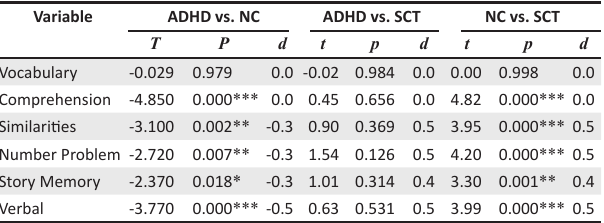
TABLE 7 : t -test scores for the differences in the mean scores of the verbal subtests between the three groups. Variable ADHD vs. NC ADHD vs. SCT NC vs. SCT